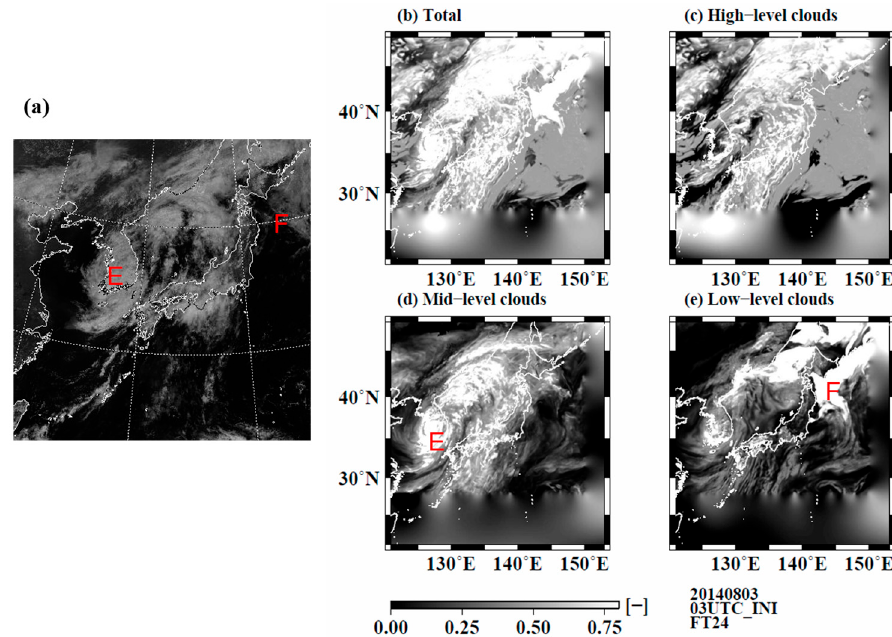
Figure 14. ( a ) Satellite-visible clouds image at 12 JST on 4 August 2014. ( b ) Total cloudiness of MSM, ( c ) high-level clouds, ( d ) mid-level clouds and ( e ) low-level clouds obtained from the day-ahead (24 h ahead) forecasts with 03 UTC initialization time, respectively.